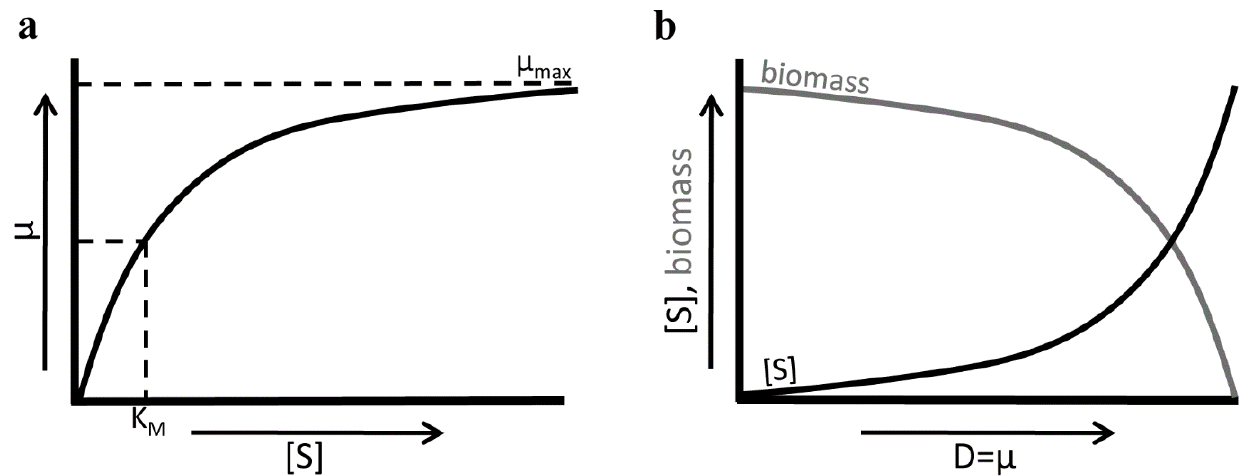
Figure 5. Jacques Monod’s relation of bacterial growth ( a ) in which the growth rate ( μ ) goes towards an upper limit ( μ max ) at high substrate concentrations ([S]) and the substrate affinity is depicted as the Monod constant (K M ), the substrate concentration at half the maximal growth rate. The Monod equation has implications for culturing in chemostat; ( b ) the growth rate is set by the dilution rate in the chemostat. The substrate concentration increases with the dilution rate (D) of the chemostat, again according to the Monod relation, thereby changing the selection pressures on microbes cultured at different Ds. At low growth rate the Monod constant is likely more important as a selection target whereas at high growth rates the maximal growth rate becomes more important, as is the case in batch